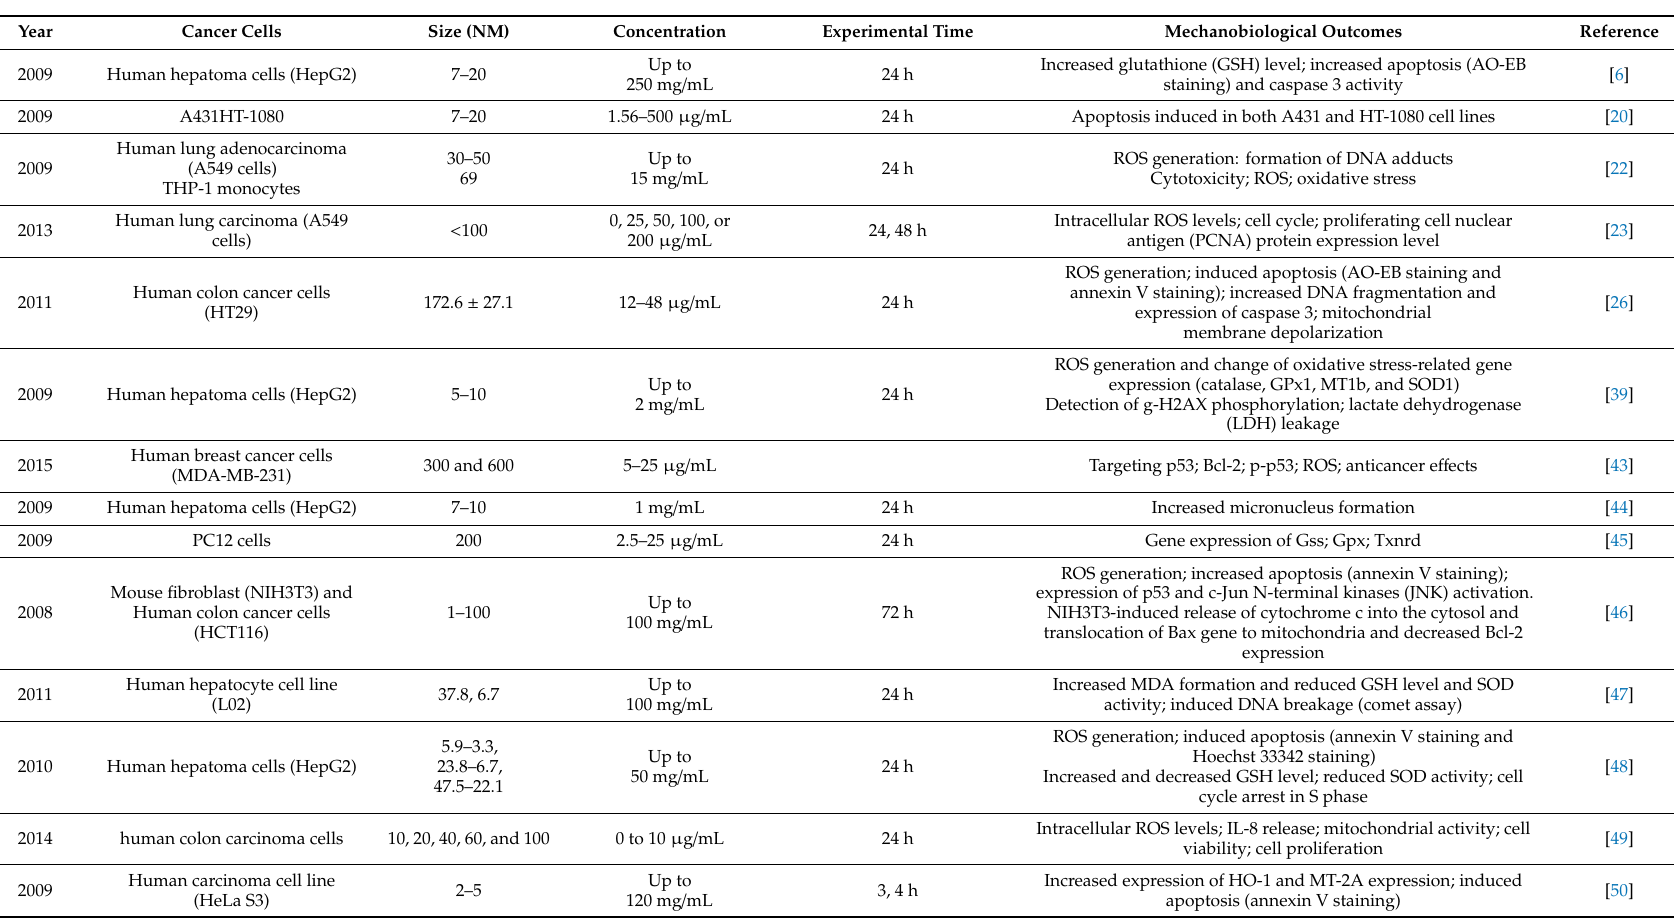
Table 1. Summary of molecular e ff ects on cancer growth controls due to the physicochemical properties of AgNPs upon exposure in in vitro